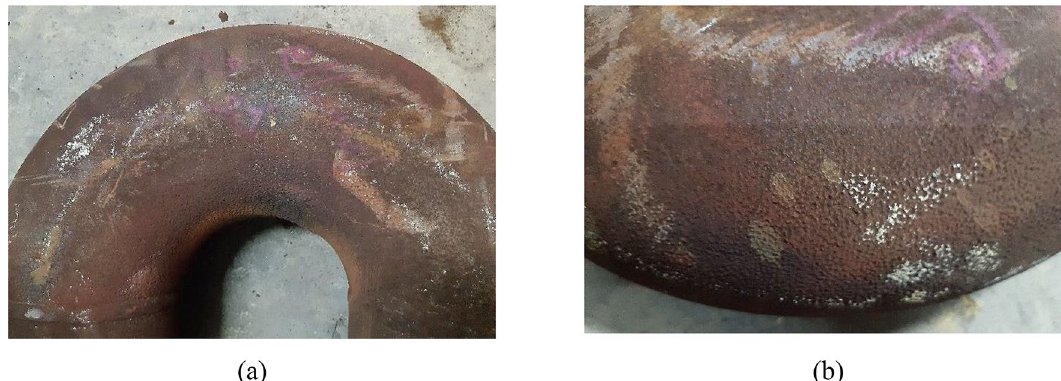
Figure 6. Images of the damaged elbow UB10–B11: ( a ) side of the elbow, and ( b ) bottom of the elbow. The elbow was at the lower part of the radiant section of the heater, and the U bend was down in service. Slight corrosion damage occurred at the bottom of the elbow. The damage is shallow